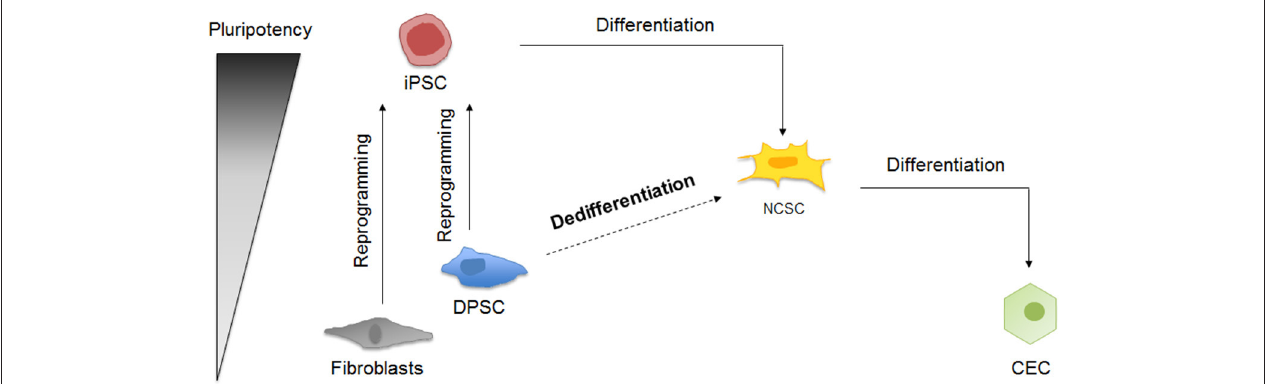
FIGURE 1 | Schematic representation of corneal endothelial differentiation based on the pluripotency levels. On the one hand, somatic cells as fibroblasts and DPSC can be reprogrammed into iPSC, which can be differentiated into NCSC and then into CEC. On the other hand, DPSC could be dedifferentiated into NCSC, and then differentiated into CEC.